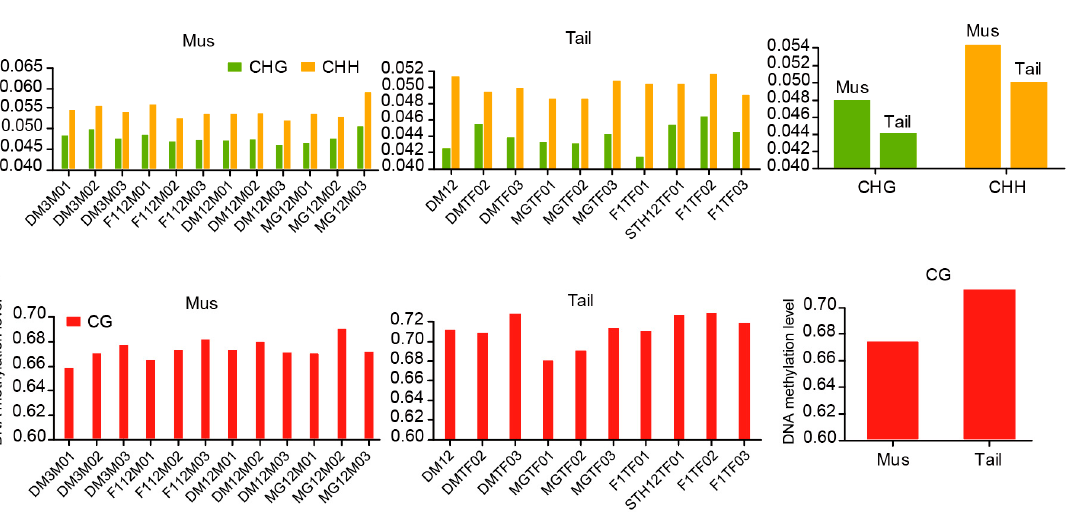
Figure 2. DNA methylation patterns under different cytosine contexts. ( A ) DNA methylation levels of CHG and CHH contexts in tail-fat tissue and muscle tissue, ( B ) DNA methylation level of CG context.